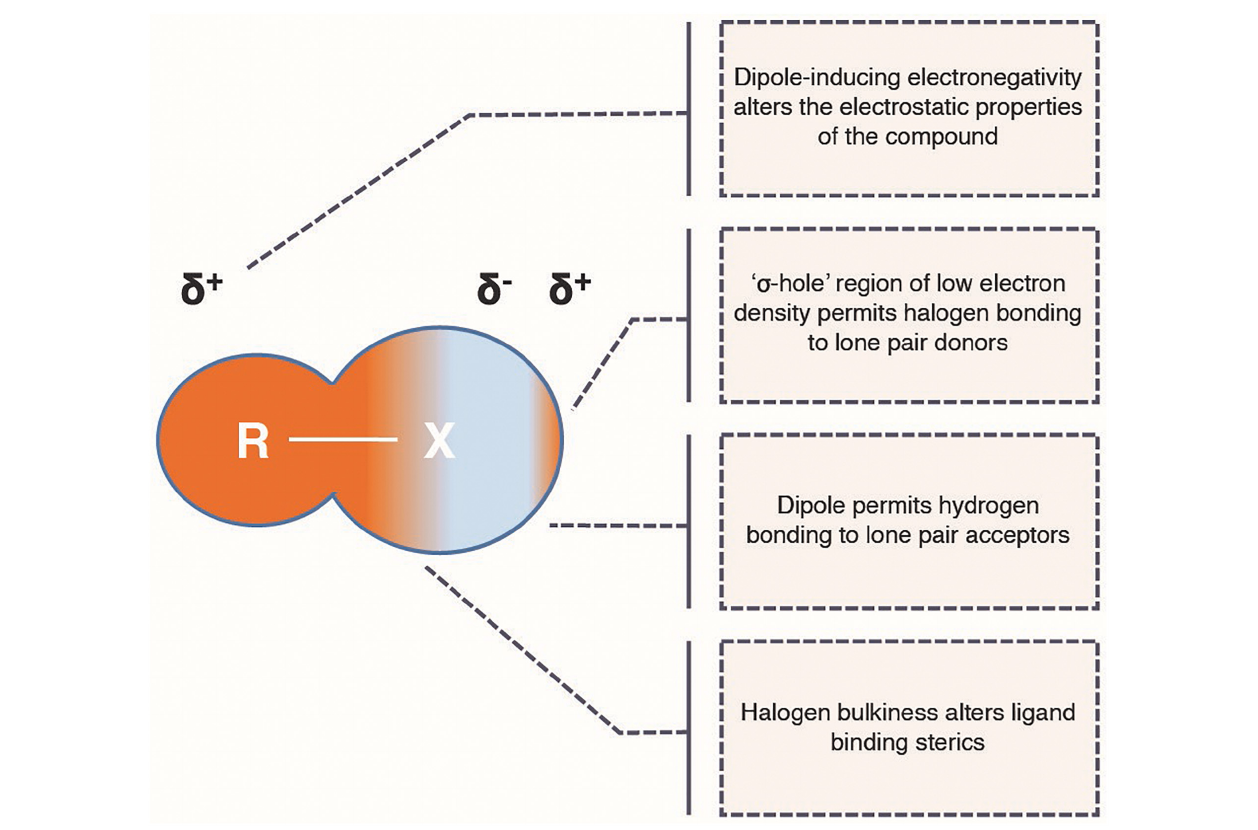
FIGURE 2 | Ligand binding properties of halogen atoms. A schematic outlining the physiochemical properties of a halogen atom (X = F, Cl, Br, or I) and its potential effects on the ligand binding properties of a pharmaceutical (R = halogen-bound atom of natural product scaffold). δ ± denote dipole partial